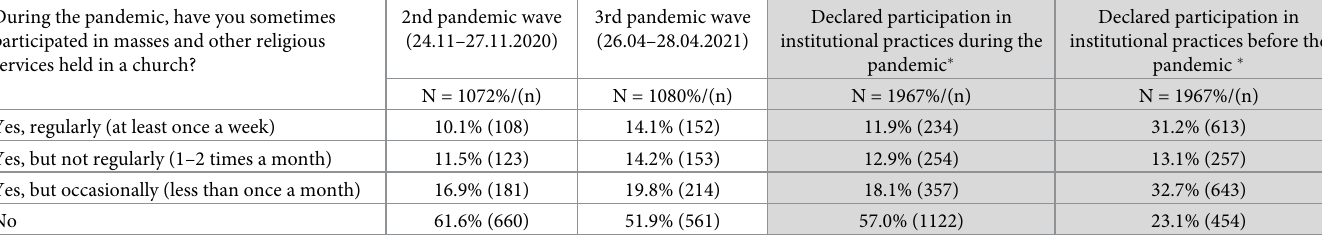
Table 2. Participation in religious services held in a church. During the pandemic, have you sometimes participated in masses and other religious services held in a